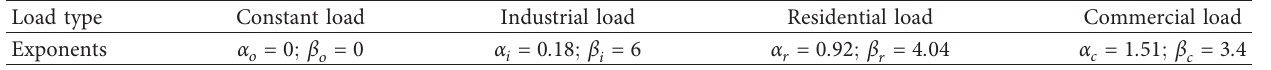
Table 1: Load types and exponent